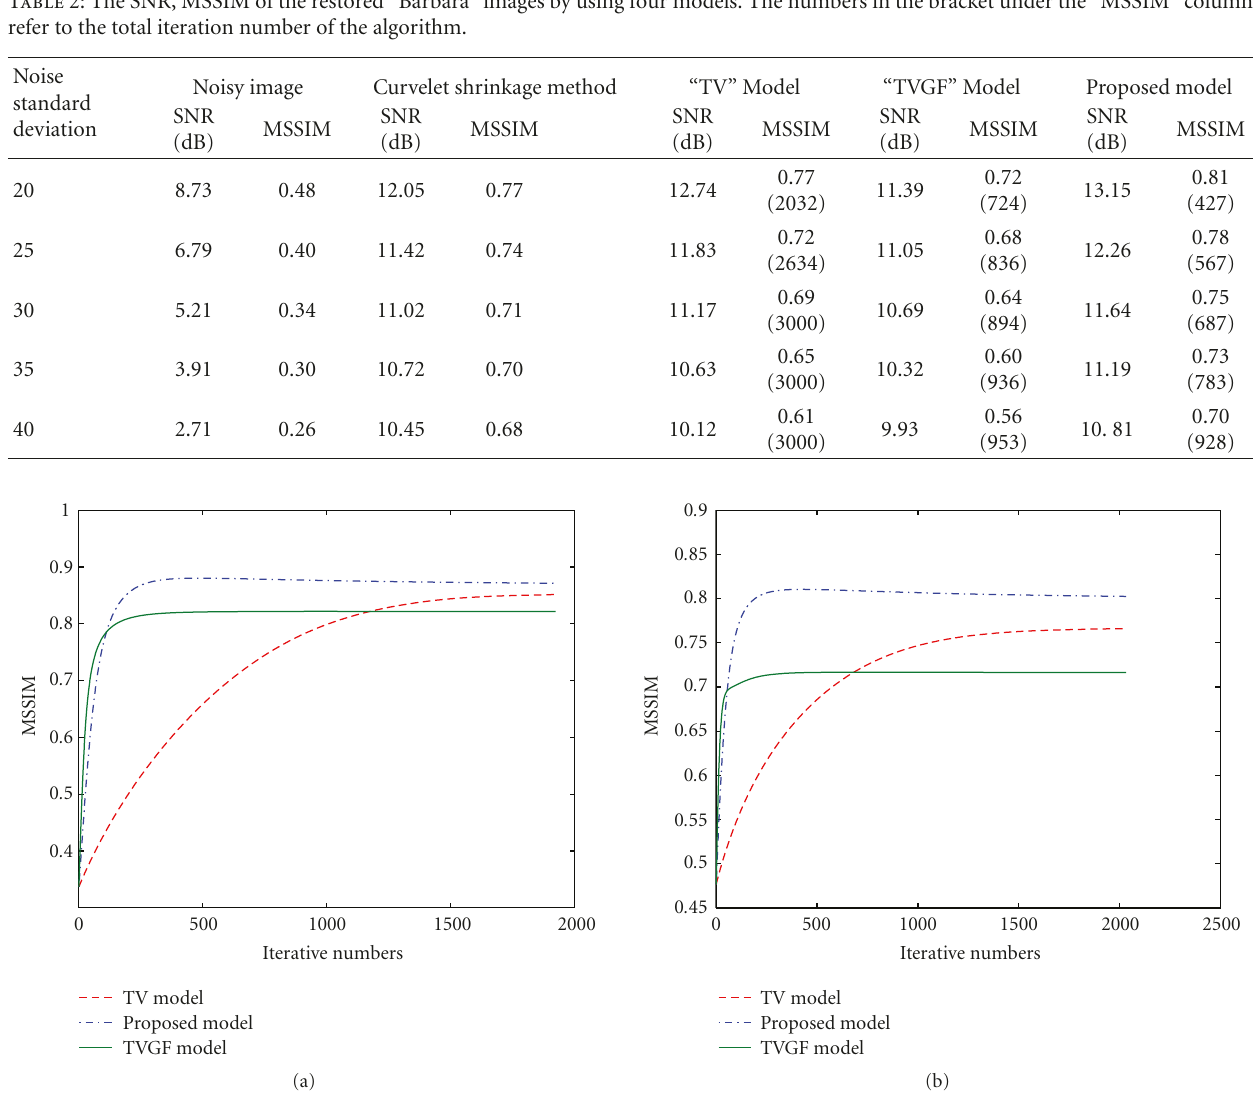
Figure 16: Comparison of the MSSIM results of the di ff erent images which is corrupted by some Gaussian noise of standard deviation 20: (a) “Lena”; (b)